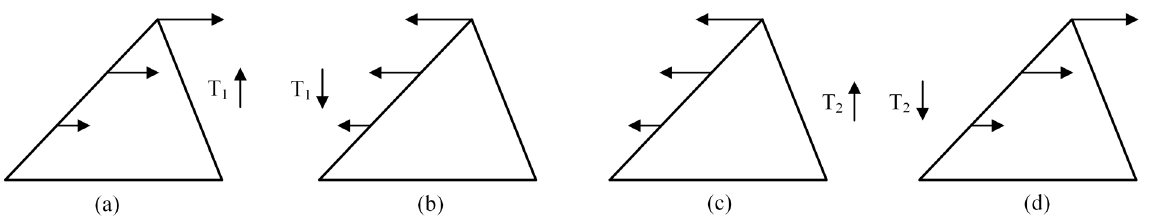
Figure 15. Influence of temperature variation on radial displacement: ( a,b) are the temperature rise and fall of the arch, respectively; ( c,d) are the temperature rise and fall of the buttress,